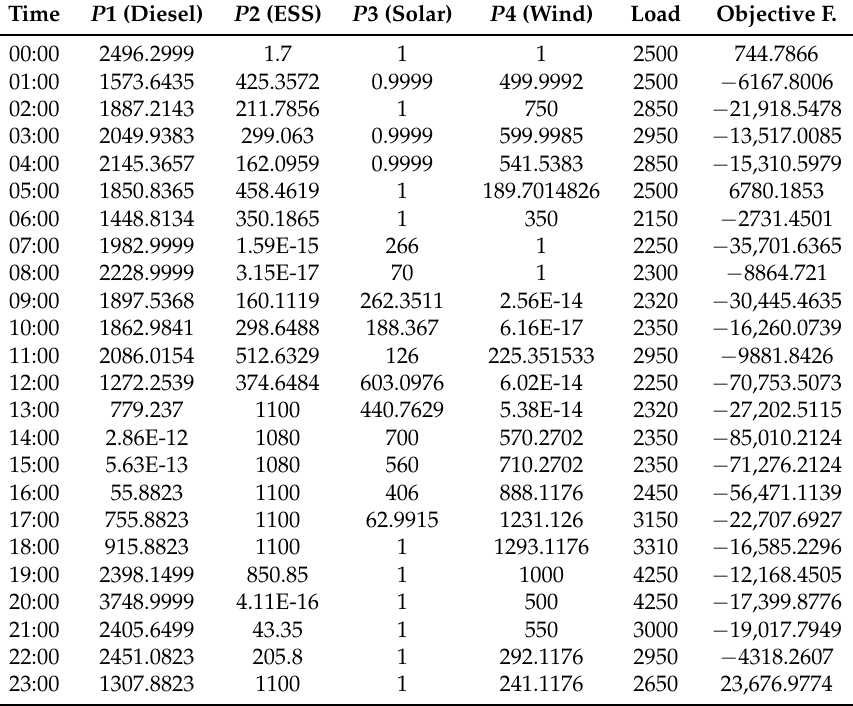
Table 9. Details of the best solution found by